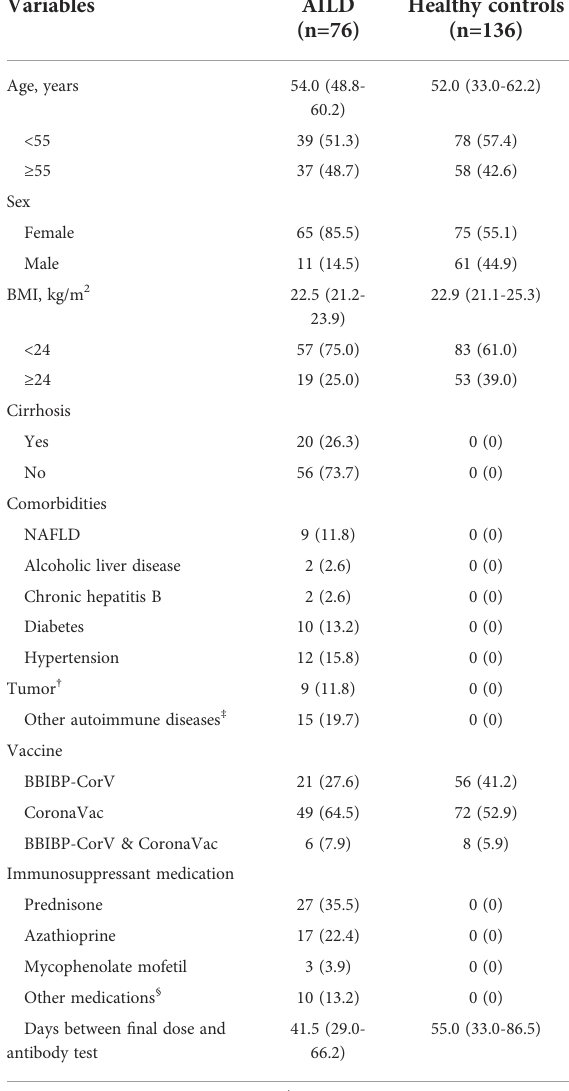
TABLE 1 Characteristics of the Participants. TABLE 2 Adverse events of COVID-19 vaccination in